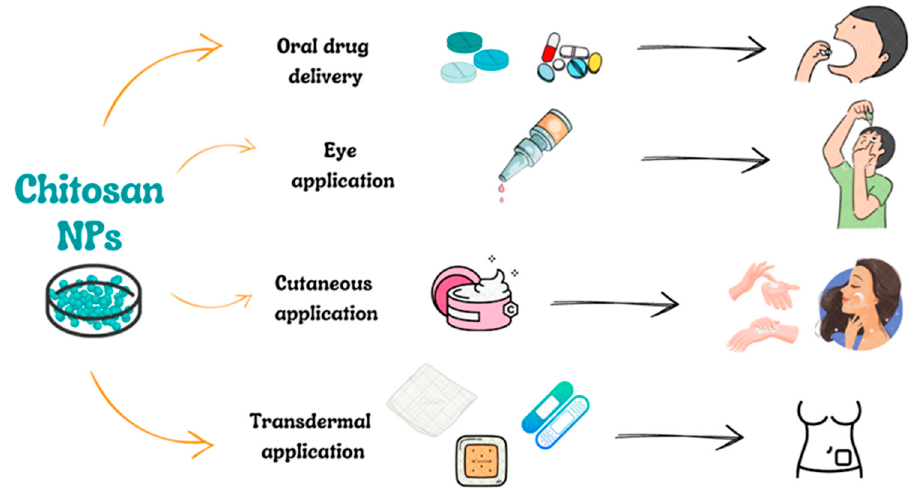
Figure 3. Scheme presenting the most popular ways of chitosan nanoparticles (ChNPs) applications.